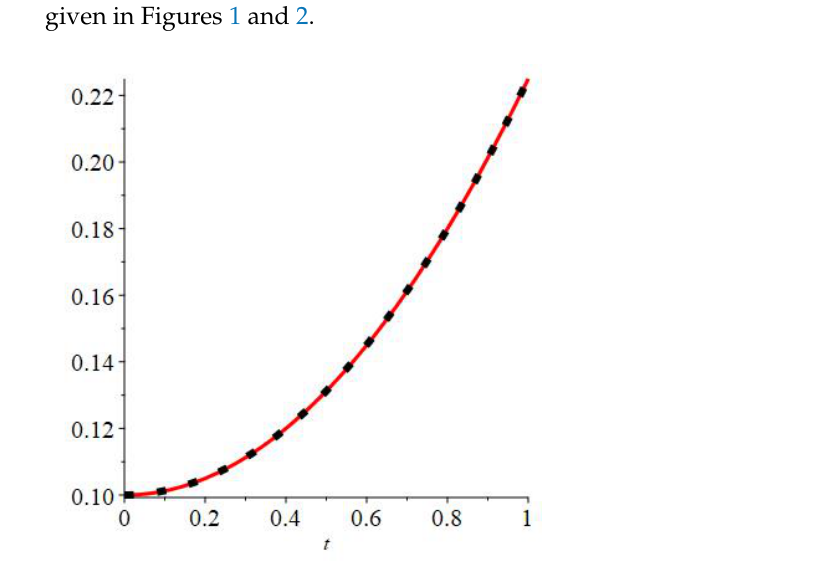
Figure 1. First components of the exact solution (solid line) and its first approximation